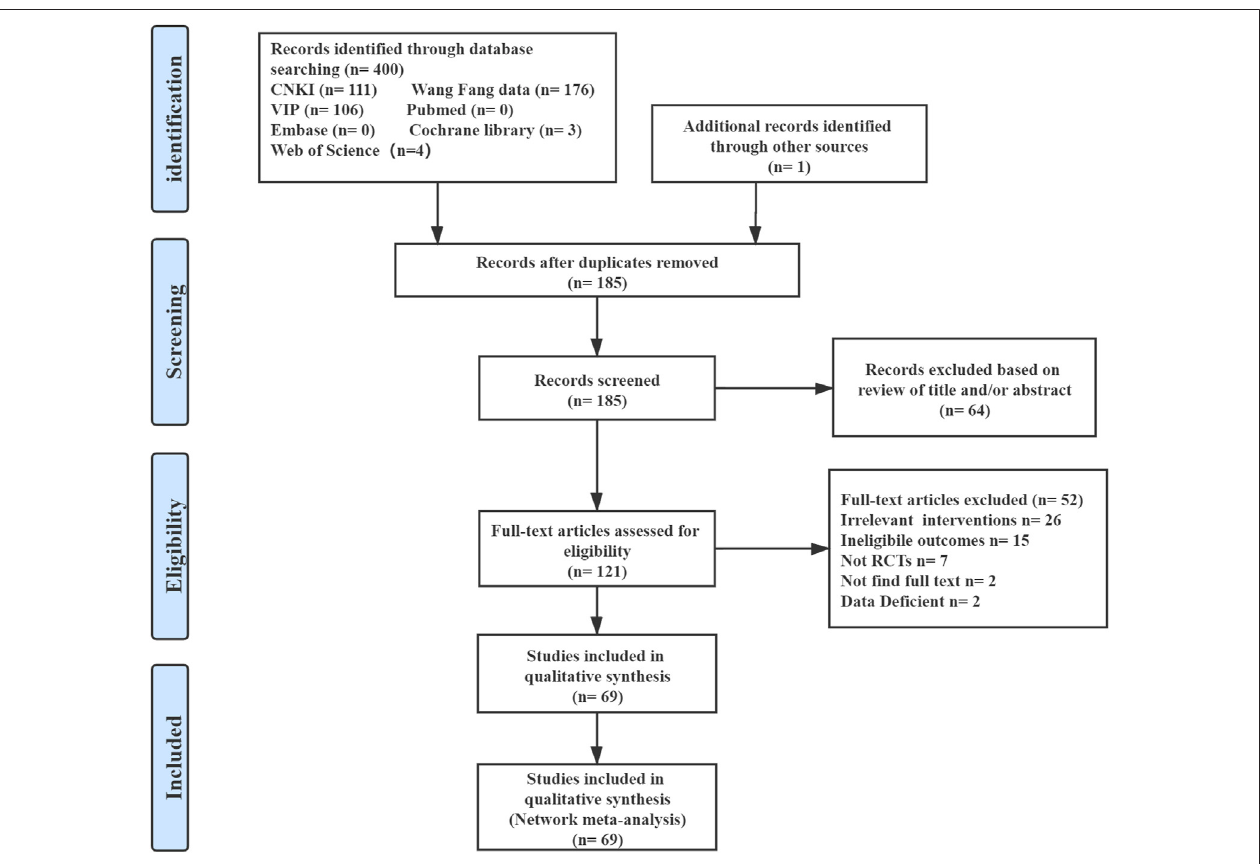
FIGURE 1 | Summary of evidence search and